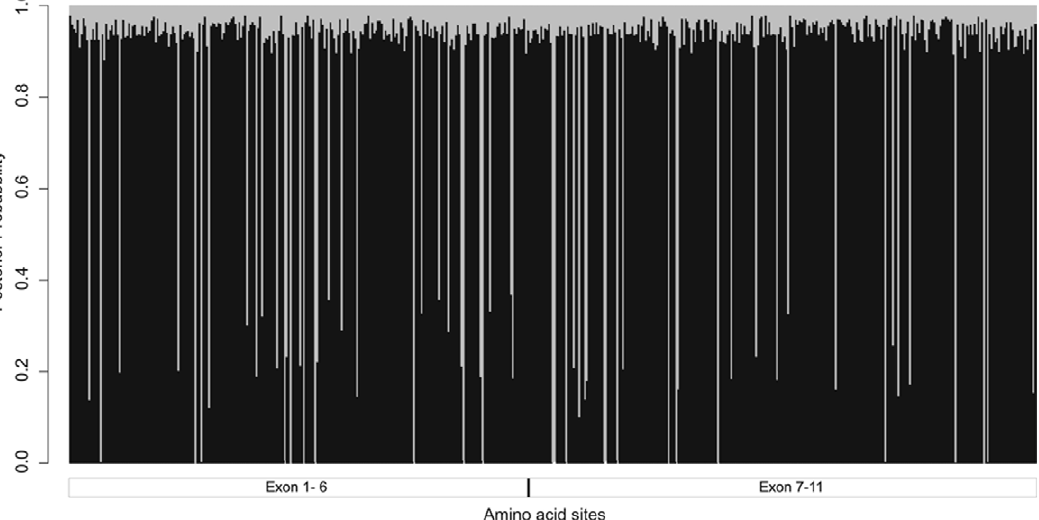
Figure 5. Probability of evolving under strong ( v s =0.007, in black) or weak ( v w =0.506, in gray) purifying selection for each of the SLC2A4 codons (in the horizontal